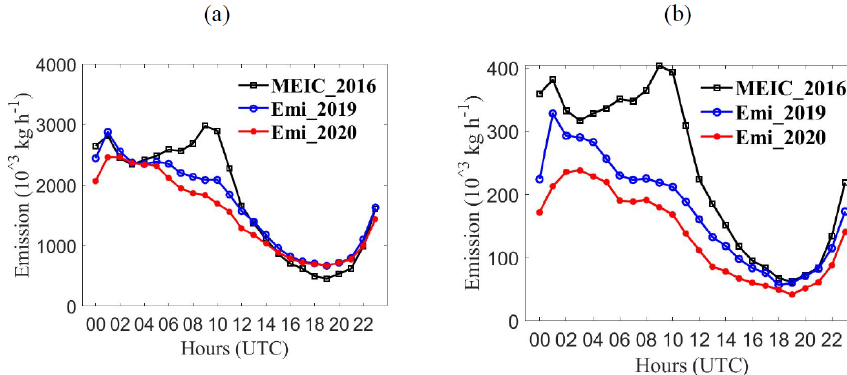
Figure 11. Hourly emissions for (a) China and (b) central China (unit: 10 3 kgh − 1 ).